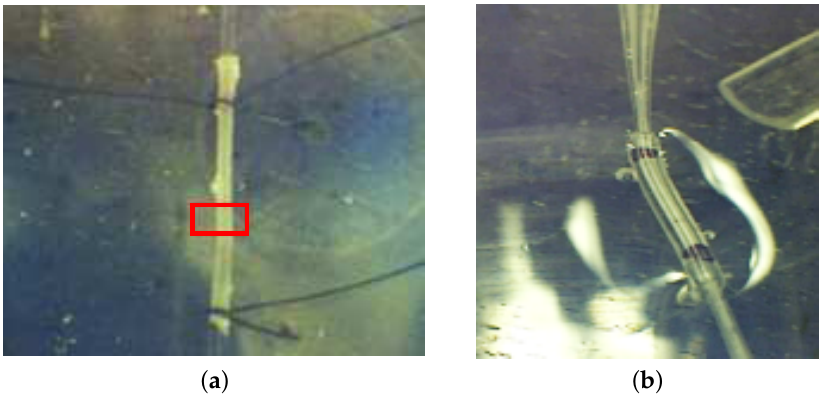
Figure 24. Diameter assessment: ( a ) rat aorta; ( b ) OFI calibration